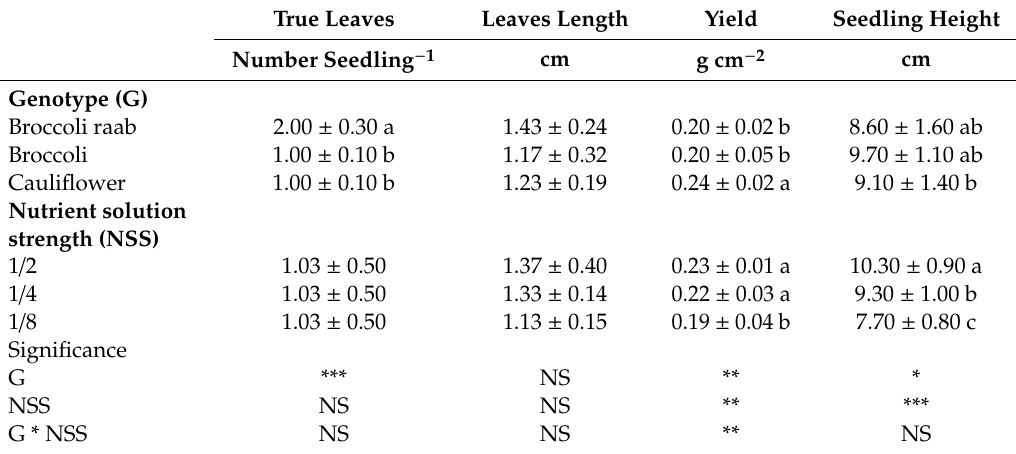
Table 3. Main e ff ects of genotypes and nutrient solution strength on number and length of true leaves, yield and seedling height of microgreens (first